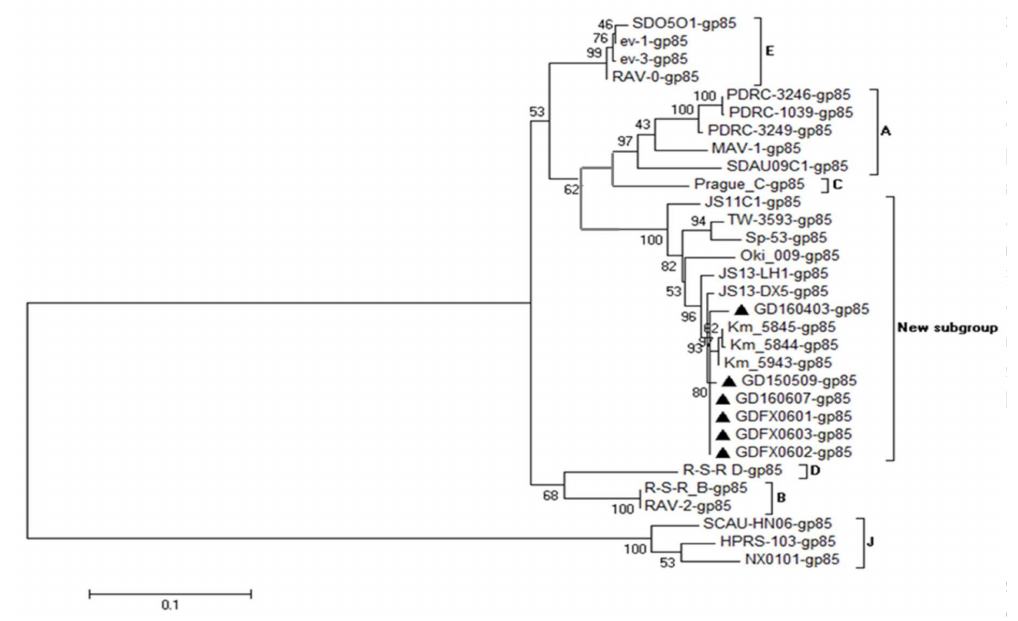
Figure 5. Phylogenetic relationship of the 6 novel isolates to reference ALV strains, based on the gp85 genome sequences. Black triangle ( (cid:78) ) indicates ALV isolates in this